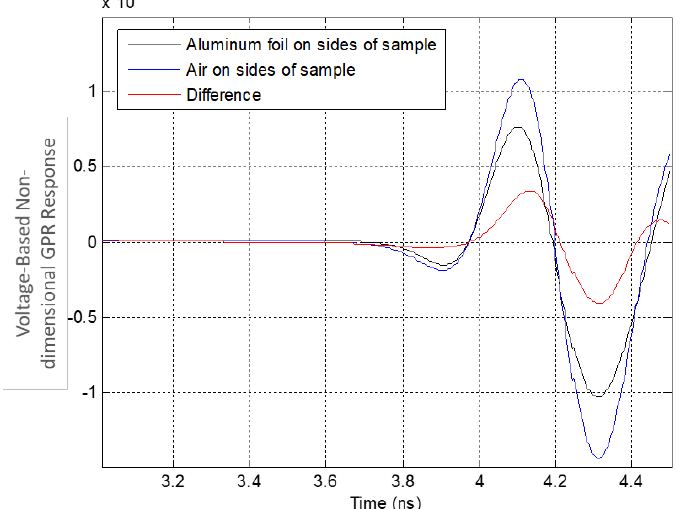
Figure 14. Isolated reflection from spacer bottom and the reflection difference at the sample bottom.